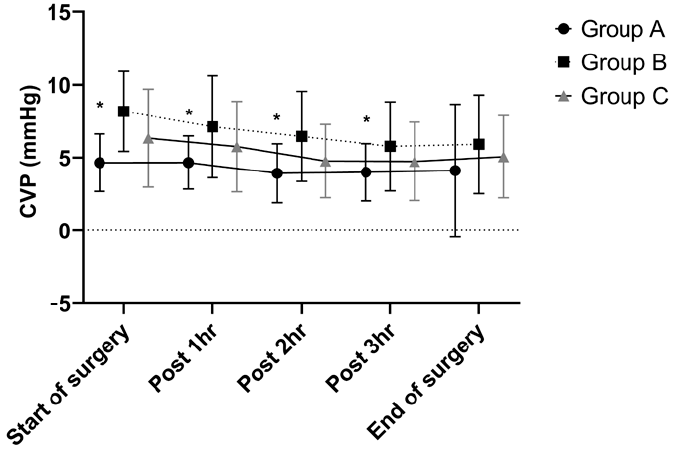
Figure 1. Changes in CVP during hepatic resection. Group A had significantly lower CVPs from the start of surgery to postoperative 3 hr than the other groups. * p < 0.05 CVP, central venous pressure. CVP continuously decreases after the start of surgery until completion of hepatic parenchymal transection, and then starts to increase post-surgery in all groups. The width of decrease was different between the groups, such that a significant difference of CVP at postoperative 4 hr was observed ( p = 0.032).